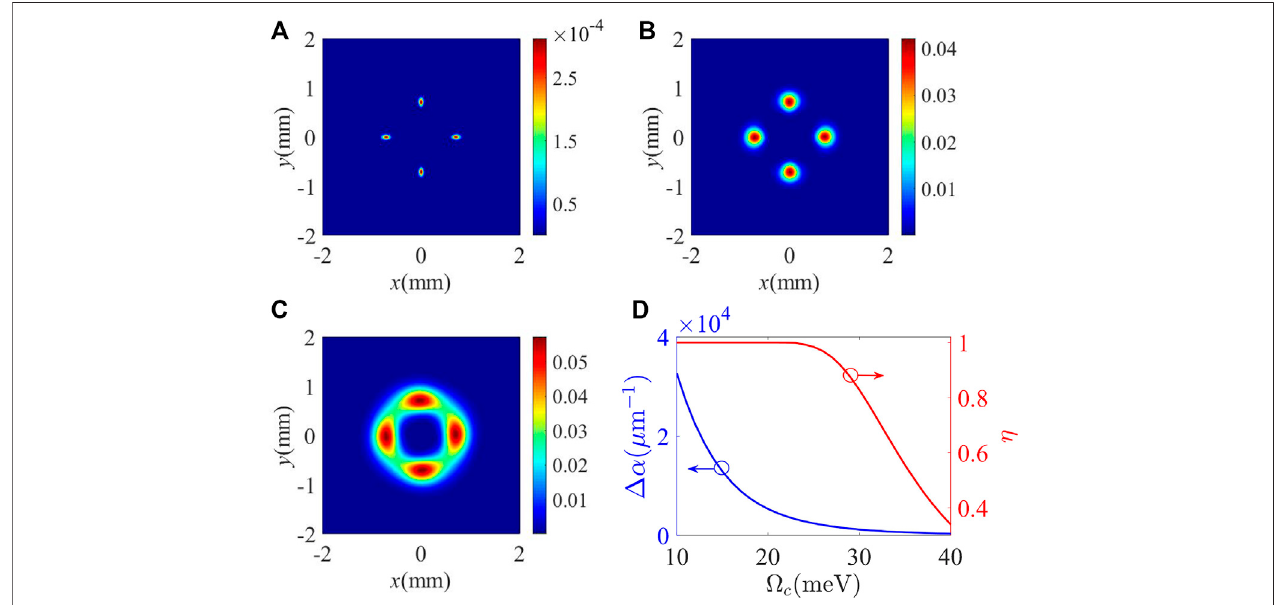
FIGURE 4 | (A – C) Intensity patterns of the FWM fi eld for different intensities of the control fi eld. (A) Ω c = 10 meV, (B) Ω c = 25 meV, and (C) Ω c = 40 meV. (D) Absorptioncoef fi cient difference Δ α andinterferencevisibility η asafunctionofintensity Ω c ofthecontrol fi eld. Otherparameters arethesameasin Figure2B except for Δ c = 8